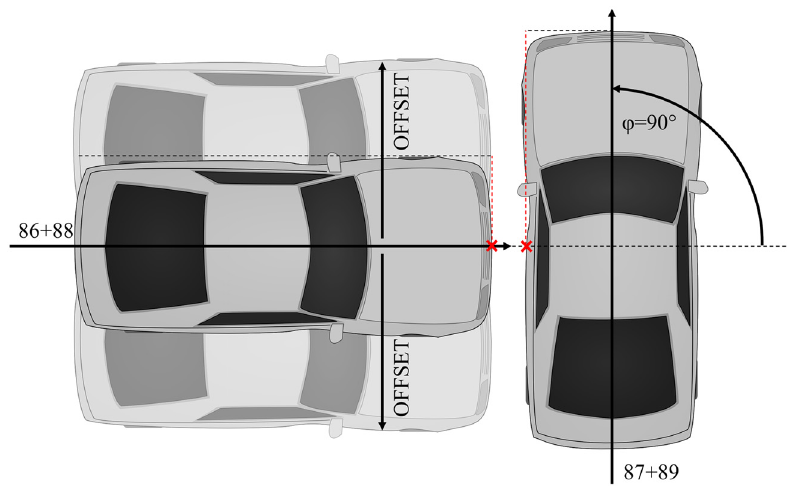
Figure A4: Collision position for scenario L – crossing trajectories 86, 87, 88, and